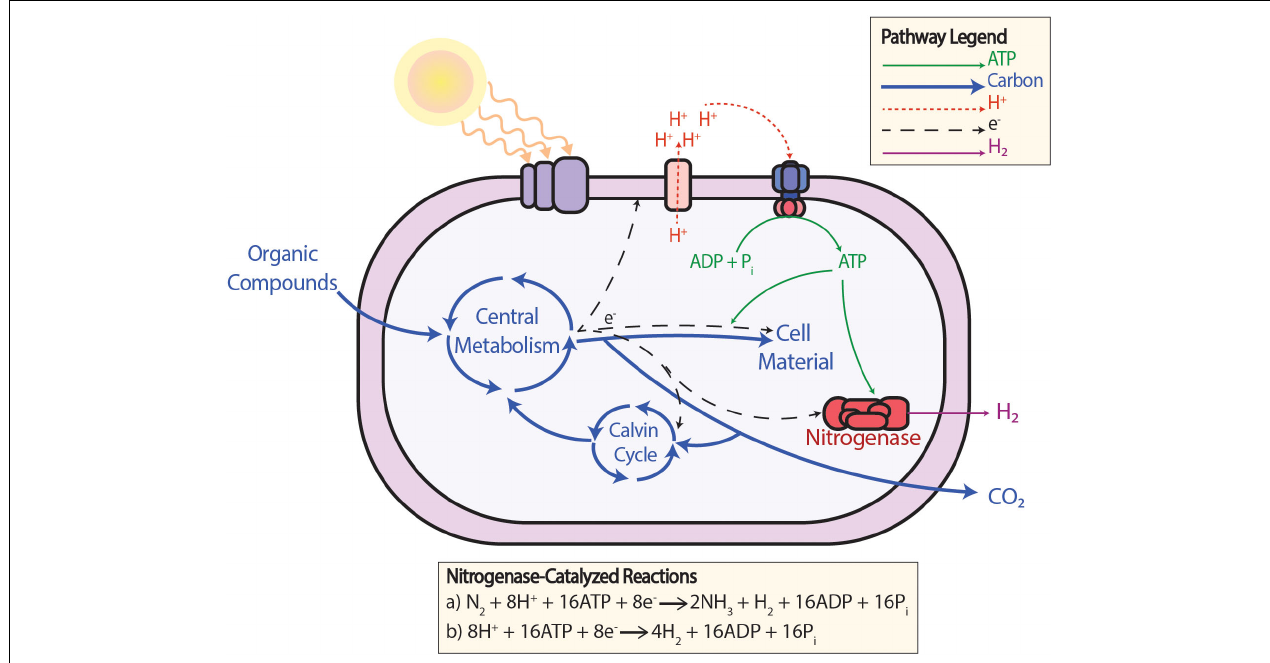
FIGURE 2 | The production of H 2 gas from the nitrogenase enzyme in PNSB under photoheterotrophic conditions. In wild-type PNSB, (a) the nitrogenase enzyme is expressed for